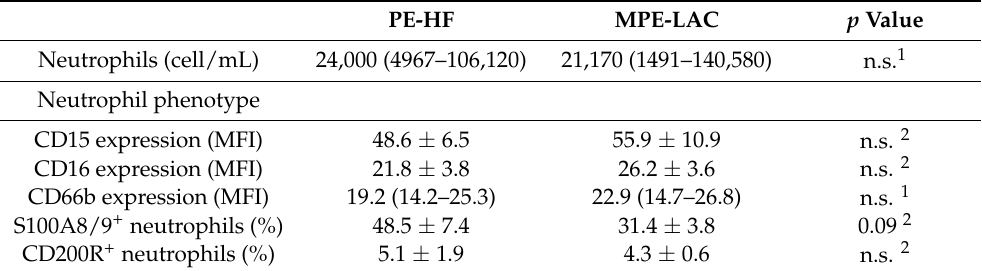
Table 2. Phenotype of neutrophils present in pleural effusions from HF and LAC.